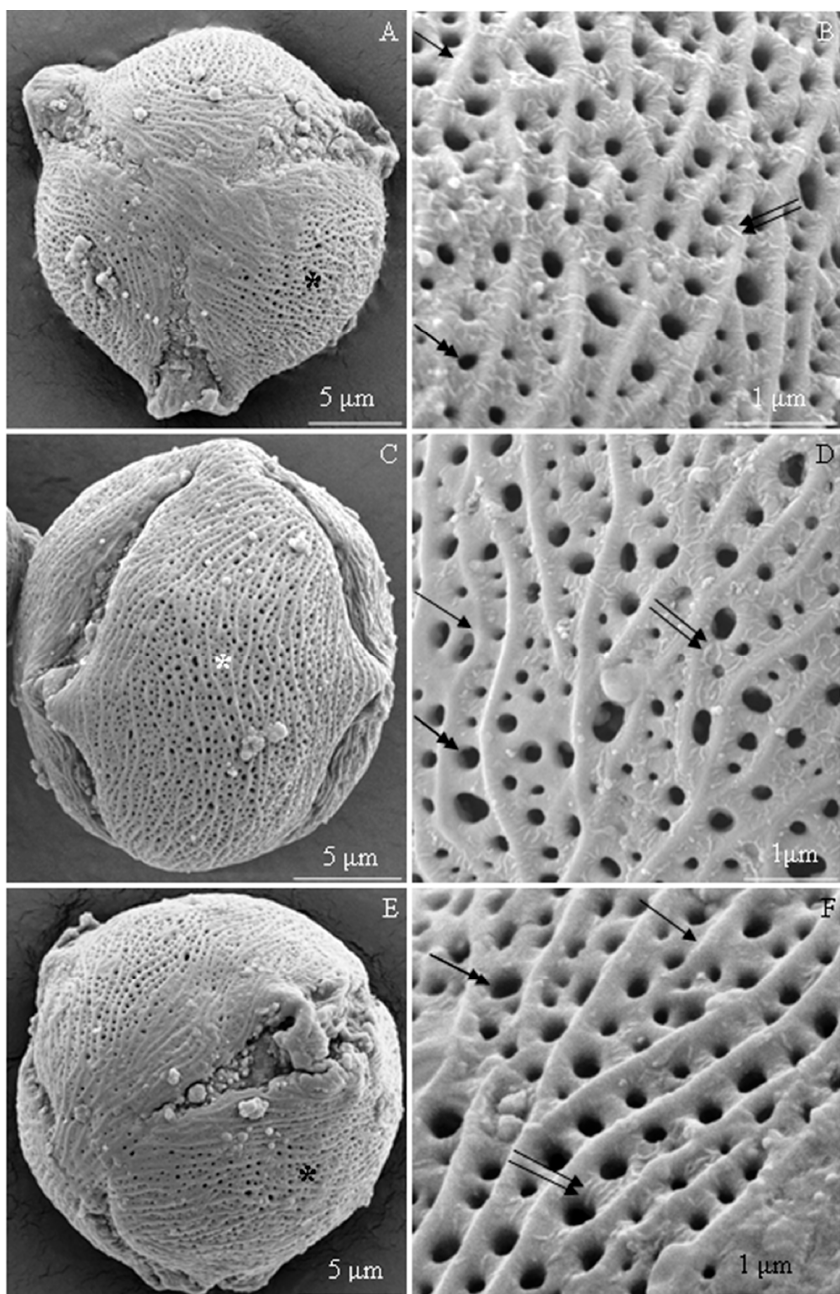
Figure 5. A – F . Pollen grains ( A , C , E ) and fragments of exine surface sculpture ( B , D , F ) in Rubus idaeus ‘Polana’: A , B —polar view, ( A ) parallel arrangement of muri in the apocolpium, arcuate arrangement, or branching between the colpi, ( B ) rows of perforations (double-headed arrow) between muri (arrow), fine striation with characteristic loose radial arrangement of striae around perforations (two arrows) perpendicular to muri; C , D —equatorial view, ( C ) parallel, undulating, and arcuate arrangement of muri along the polar axis, ( D ) striated-perforated exine sculpture, distinct undulating muri, branching in some areas, fine striae in radial arrangement at the perforations (double arrow); ( E )—equatorial view of a grain, visible colpus with a porus and pollenkitt (arrowhead); ( F )—rows of perforations (double-headed arrow) in the colpi of parallel muri (arrow) with a semicircular curve, dichotomously branched muri along the polar axis, fine striae around perforations (double arrow) and perpendicular arrangement on the surface of muri. A – F - SEM.